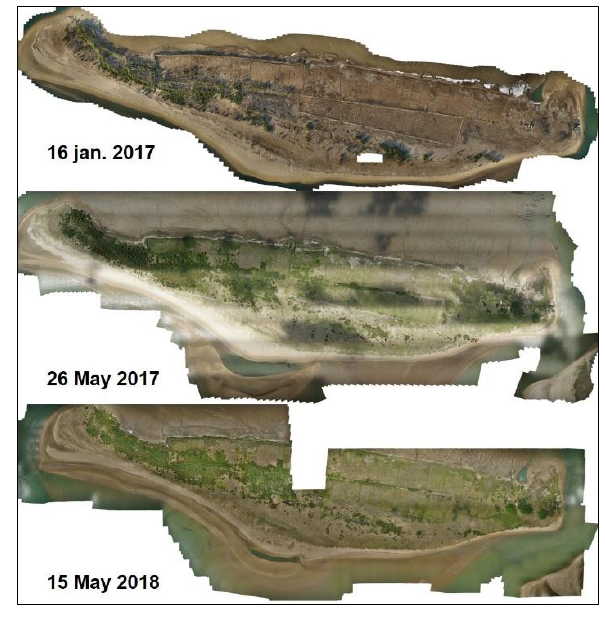
Figure 4. Orthophotos of Jinu-do